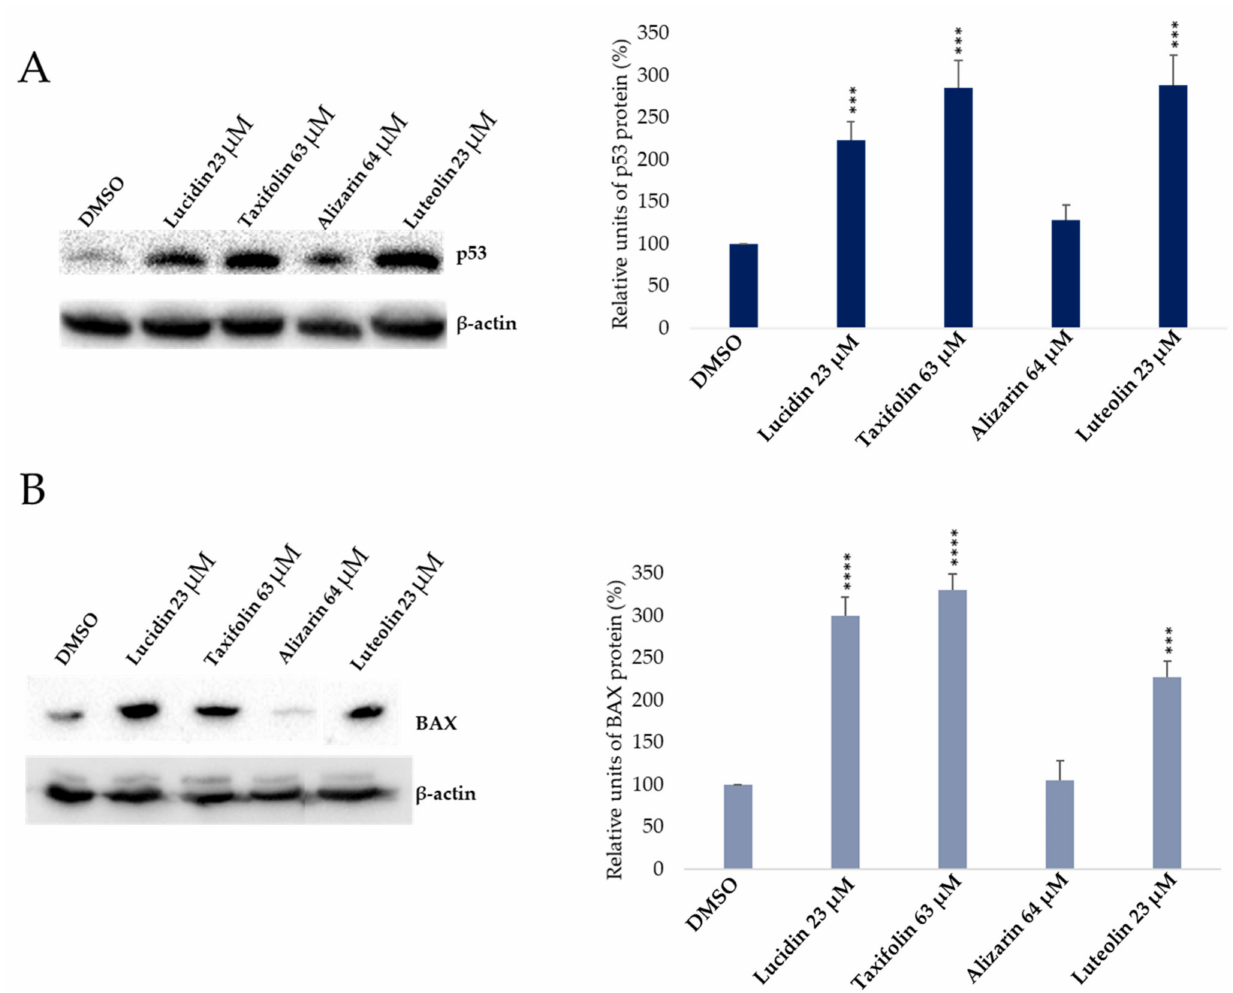
Figure 6. The effect of anthraquinones and flavonoids on p53 ( A ) and BAX ( B ) protein levels in HPV-positive Hela cells was evaluated by Western blot analysis after 48 h of treatment. Data were normalized against the β -actin and plotted as a percentage related to the DMSO-treated cells. Each data set represents the mean ± SD for three independent experiments ( n = 3) performed with samples acquired in three independent in vitro studies analyzed by the t -Student test. Significance was determined as p -values *** < 0.001, **** <